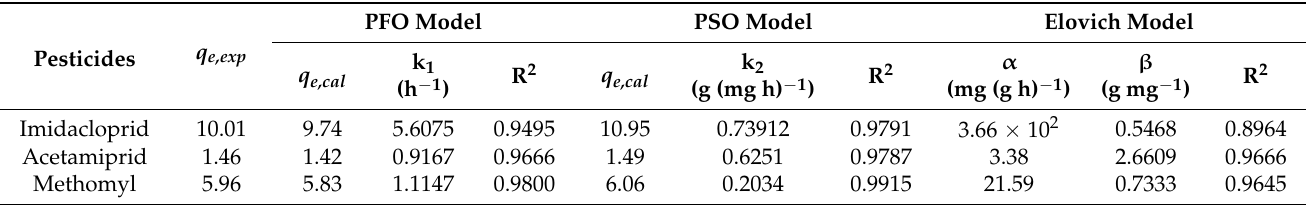
Table 5. Kinetic parameters of the PFO, PSO and Elovich models for adsorption of imidacloprid, acetamiprid and methomyl on the eucalyptus wood-derived biochar. q e,exp : experimental adsorption capacity and q e,cal : calculated adsorption capacity (mg g − 1